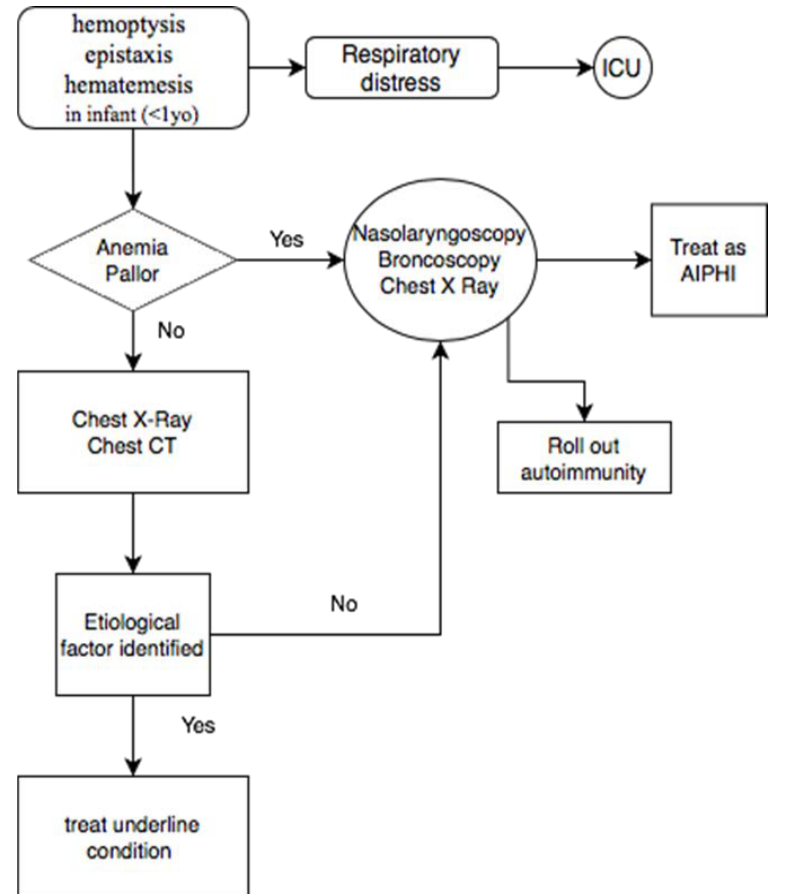
Figure 3. Diagnostic flowchart for patients presenting symptoms related to AIPHI.